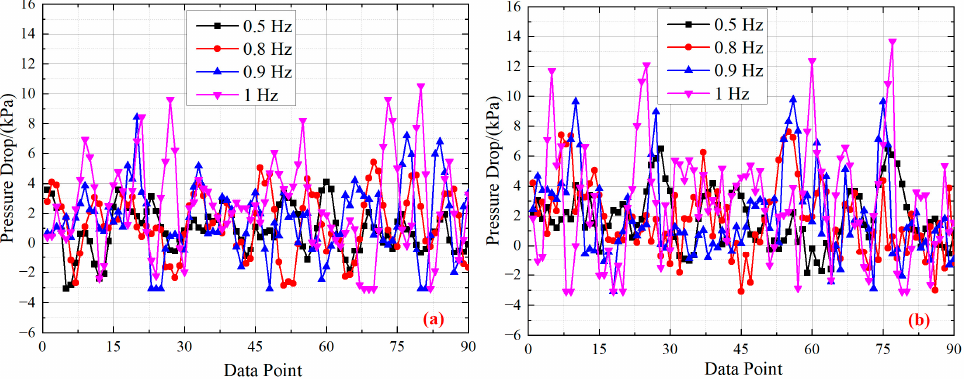
Figure 4. Different stages of flow instability at various frequency ( J w = 1.1 m/s): ( a ) J g = 1.0 m/s, A = 62 mm, ( b ) J g = 1.0 m/s, A = 106 mm.